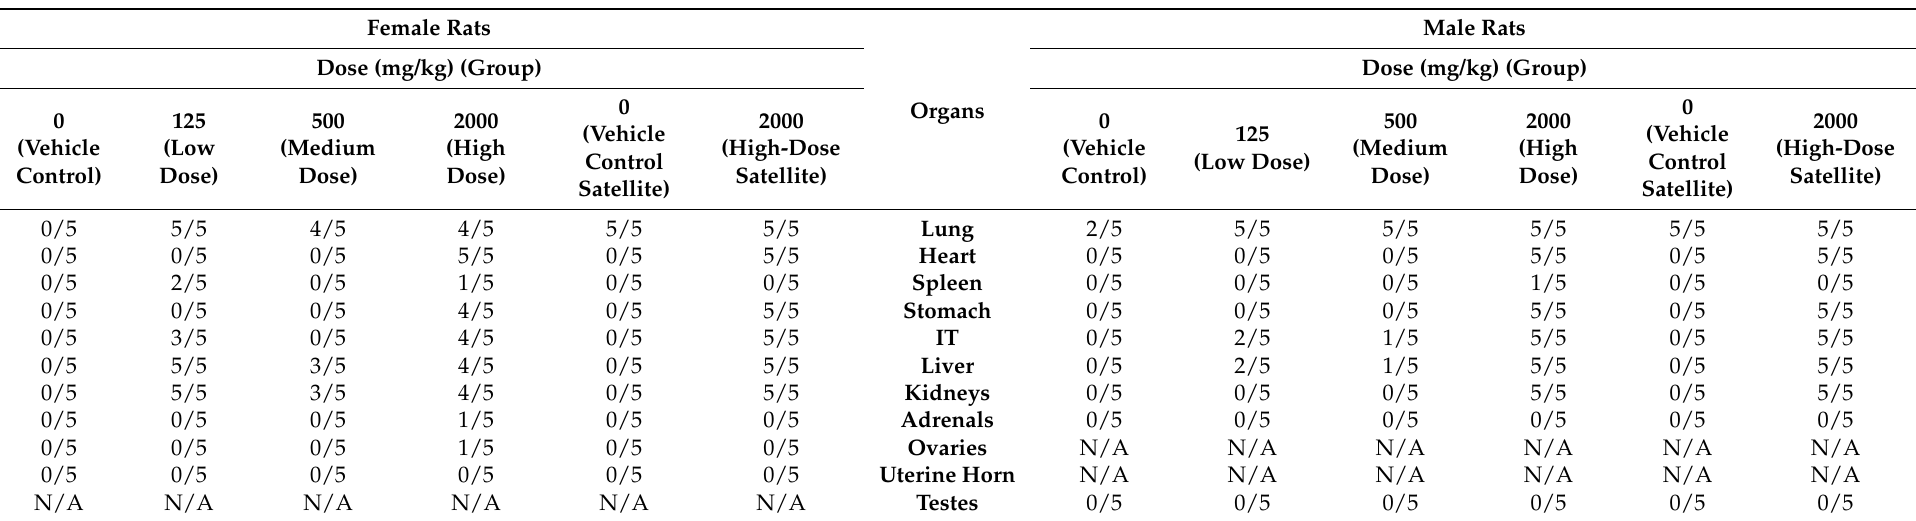
Table 12. Summary of microscopic findings in female and male